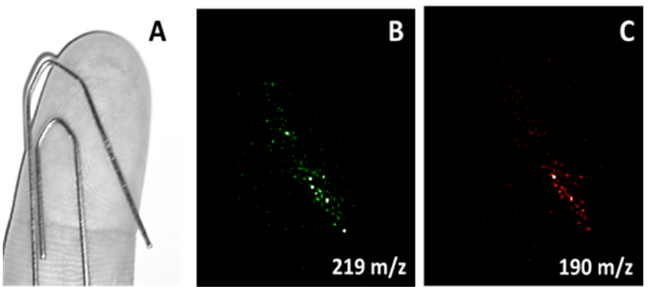
Figure 6. Exogenous compounds in LFM. The chemical image of the fingerprint retains the details of the object touched with the finger. ( A ) Optical image; ( B , C ) acetyl salicylate and acetaminophen chemical images on the LFM, respectively.